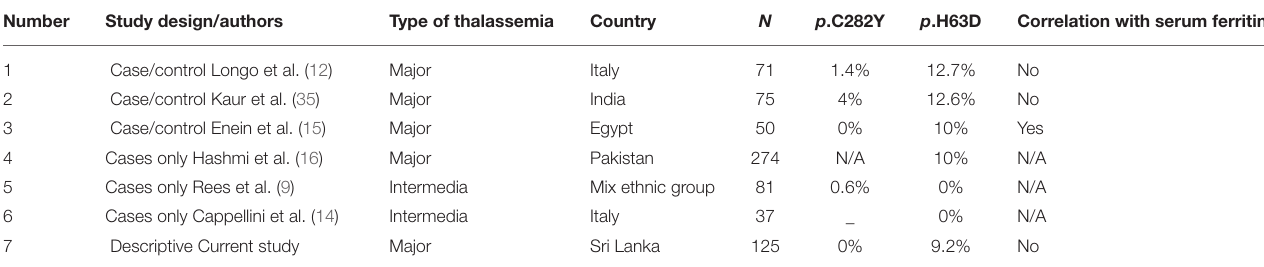
TABLE 4 | The HFE gene mutation analysis: summary of previous studies done on β thalassemia major and intermedia patients and the present study.